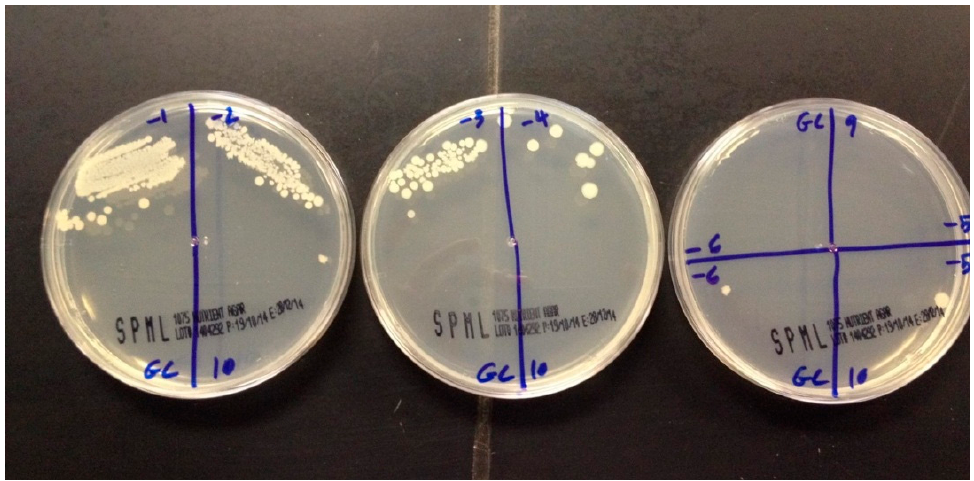
Figure 1. Different cultures showing different concentrations of Candida colonies.